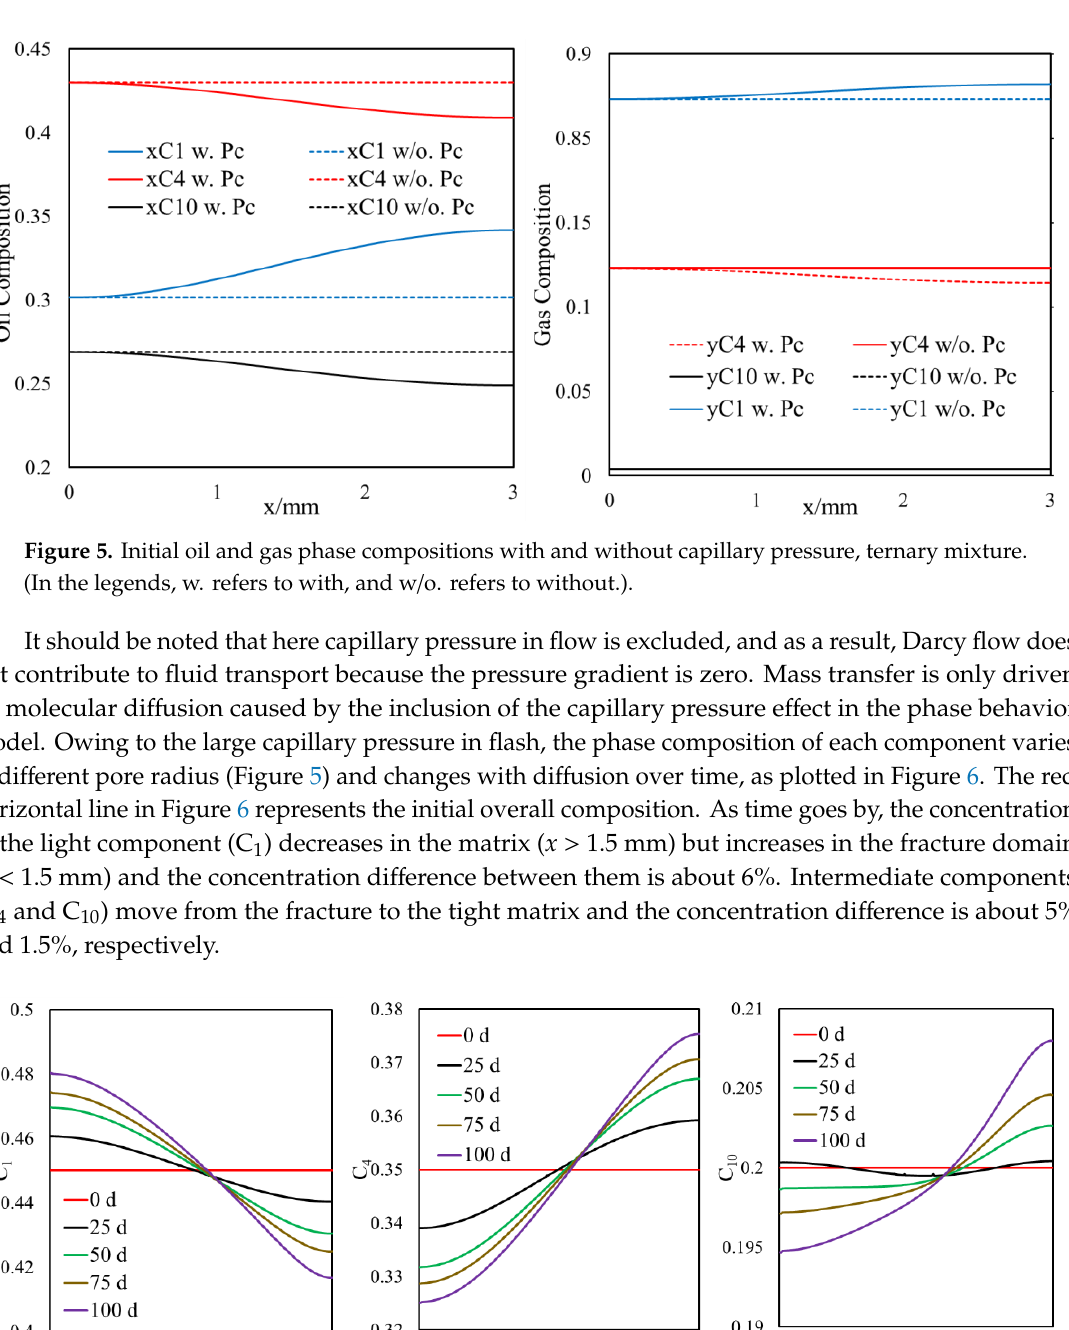
Table 3. Binary interaction parameters for the C 1 /C 4 /C 10 system.